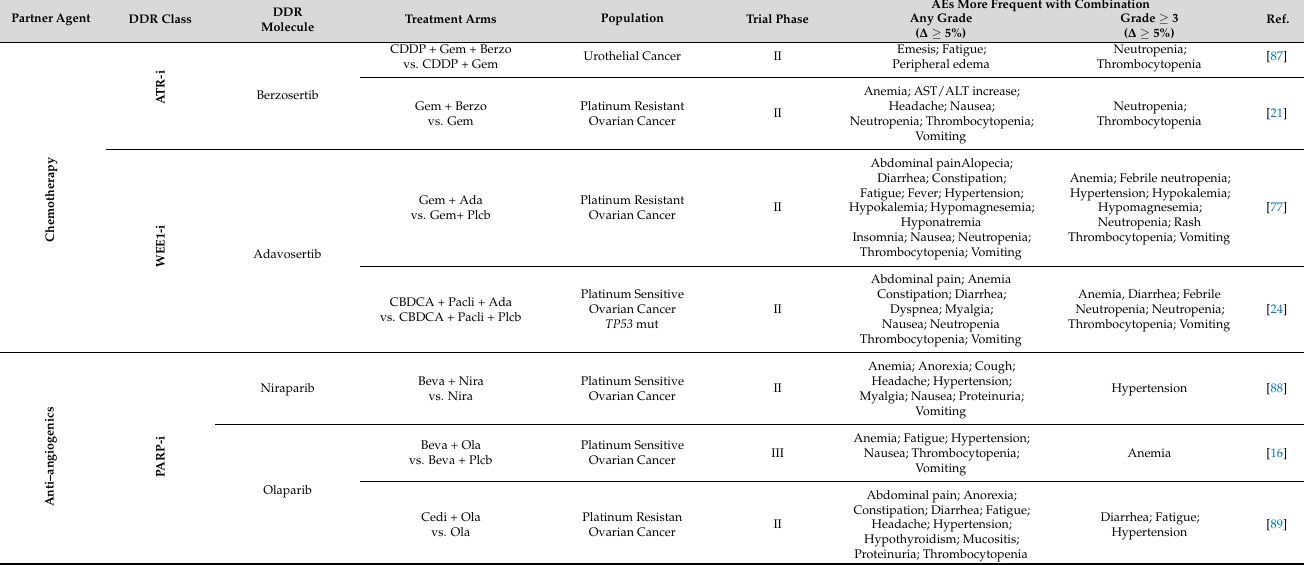
AEsMoreFrequentwithCombination